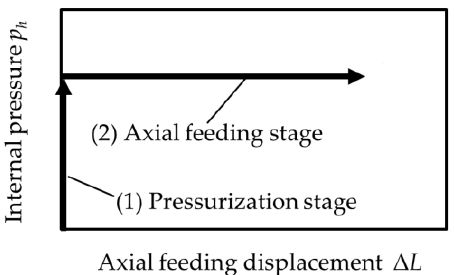
Figure 8. Schematic of the loading path used in the experiment and finite element (FE) method (FEM).